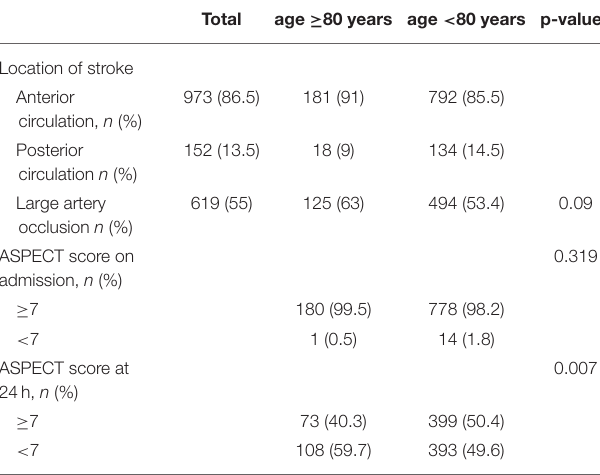
TABLE 2 | CT characteristics of patients above and under 80